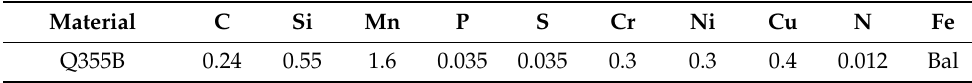
Table 2. Chemical composition (wt.%) of the Q355B